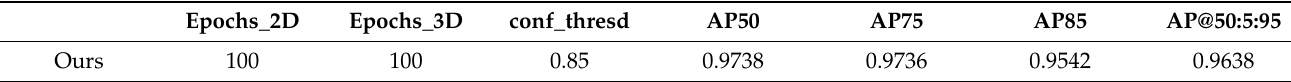
Table 5. Two- level detection results.